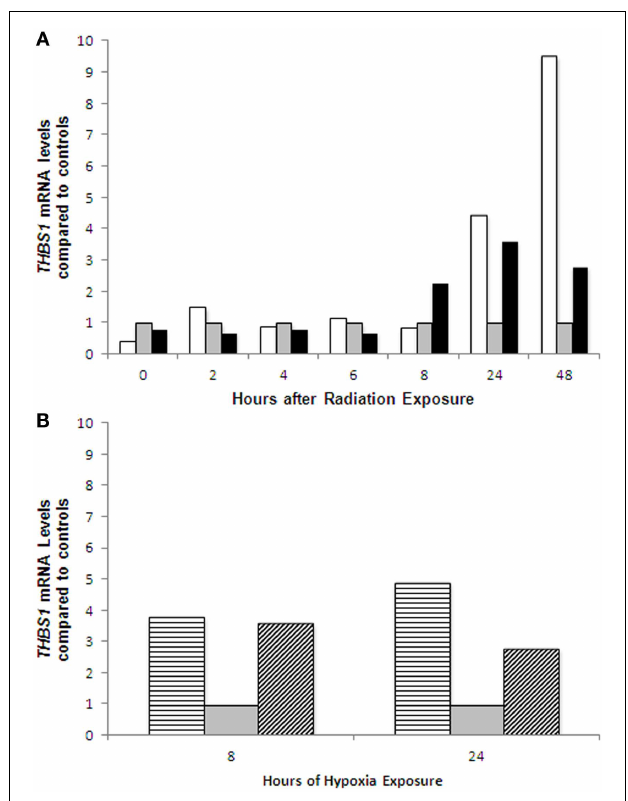
FIGURE 4 | THBS1 mRNA expression in ovarian cancer cell lines following radiation and hypoxia treatment . Induction of THBS1 transcription in the parent A2780wt TP53 cells and A2780m TP53 cells following radiation treatment (A) ; and hypoxia exposure (B) . After